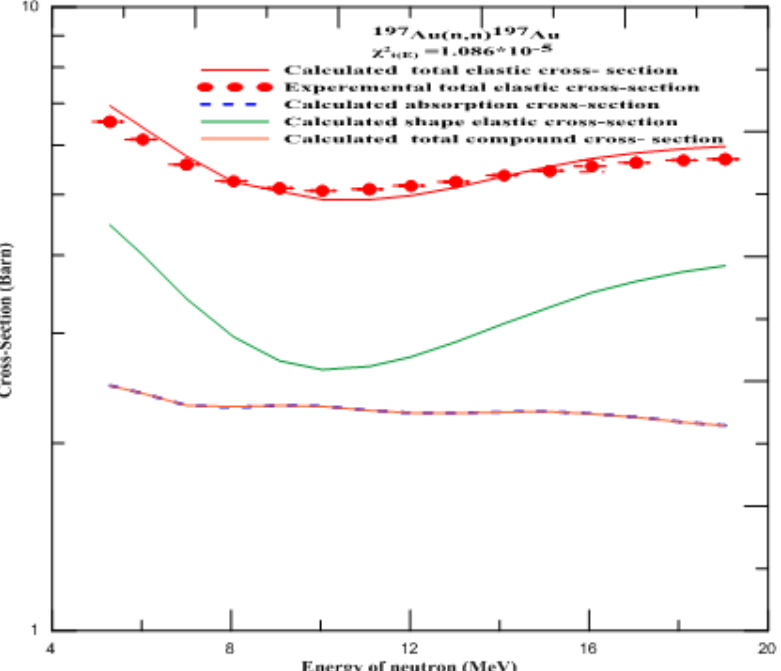
Fig. 2: The present calculated total Integral Cross-Section using SOM for neutron energy scattering on 197 Au nuclei at different energies compared with experimental data [26,